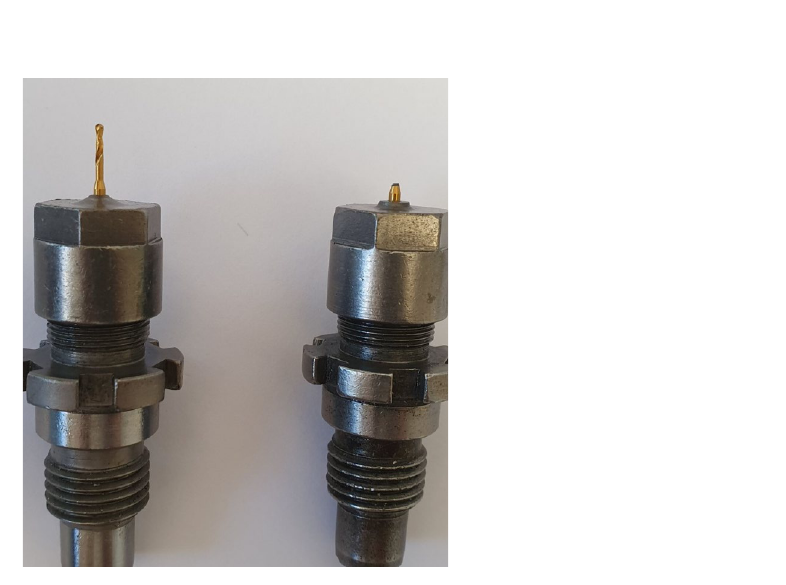
Figure 2. A healthy drill bit (on the left side) and a broken drill bit (on the right side) 1